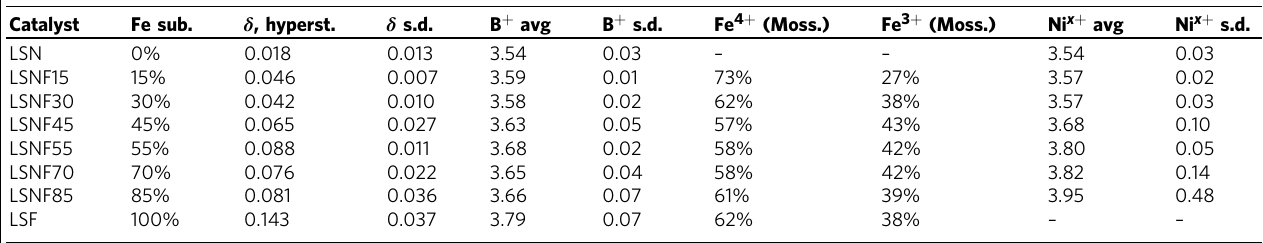
Table 1 Oxygen hyperstoichiometry ( δ ) and B-site oxidation states in La 0.5 Sr 1.5 Ni 1 − x Fe x O 4± δ LSNF series oxidation state characterization Catalyst Fe